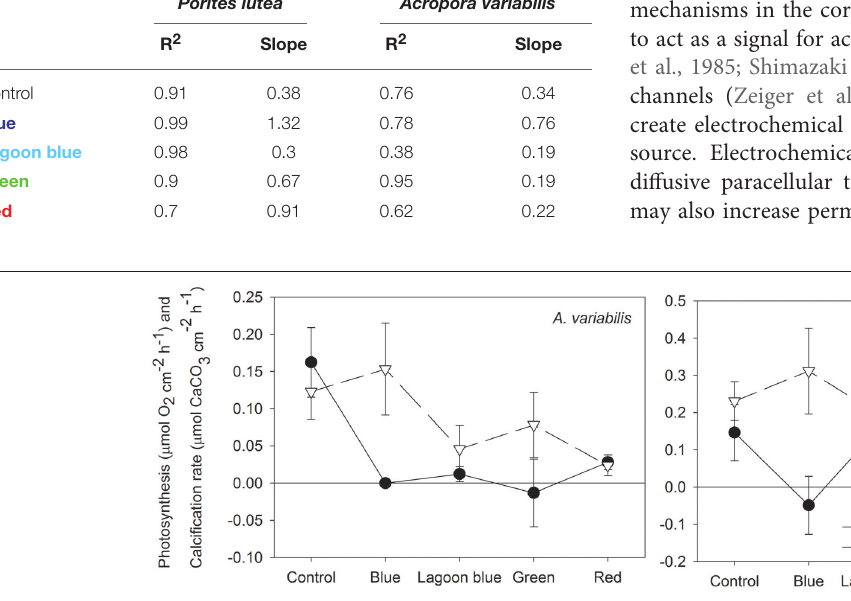
Frontiers in Marine Science |